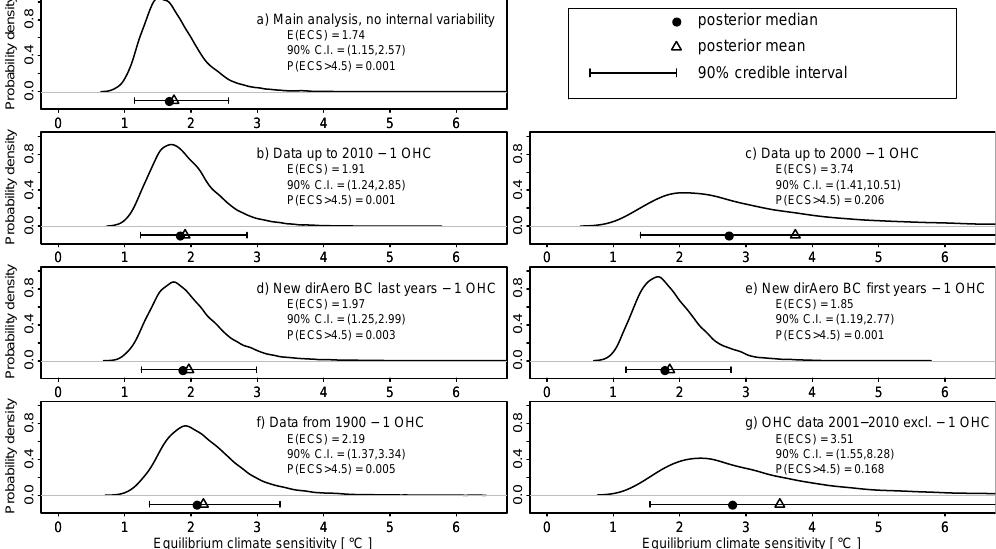
Fig. E1. Posterior distributions for the ECS for analyses where long-term internal variability is not included explicitly in the model (i.e. the term n liv t is not included in the model) and only one OHC series is used (except for the analysis in (a) that is included to show the effect of using three instead of one OHC series). In (a) the main analysis (no long-term internal variability term, three OHC series), (b) only one OHC series, (c) use data up to 2000, (d) sensitivity Test 1, changing the direct aerosol BC effect in the latter part of the simulation period, (e) sensitivity Test 2, changing the direct aerosol BC effect in the early part of the simulation period, (f) sensitivity Test 3, using data between 1900 and 2010, (g) sensitivity Test 4, excluding OHC data for the years 2001 to 2010. The estimated mean of ECS, the 90%C.I. and the probability of ECS being larger than 4.5 ◦ C are given in the text box of each panel. The 90%C.I. (the error bar) and estimated posterior mean (triangle) and median (black dot) are also indicated in each panel.